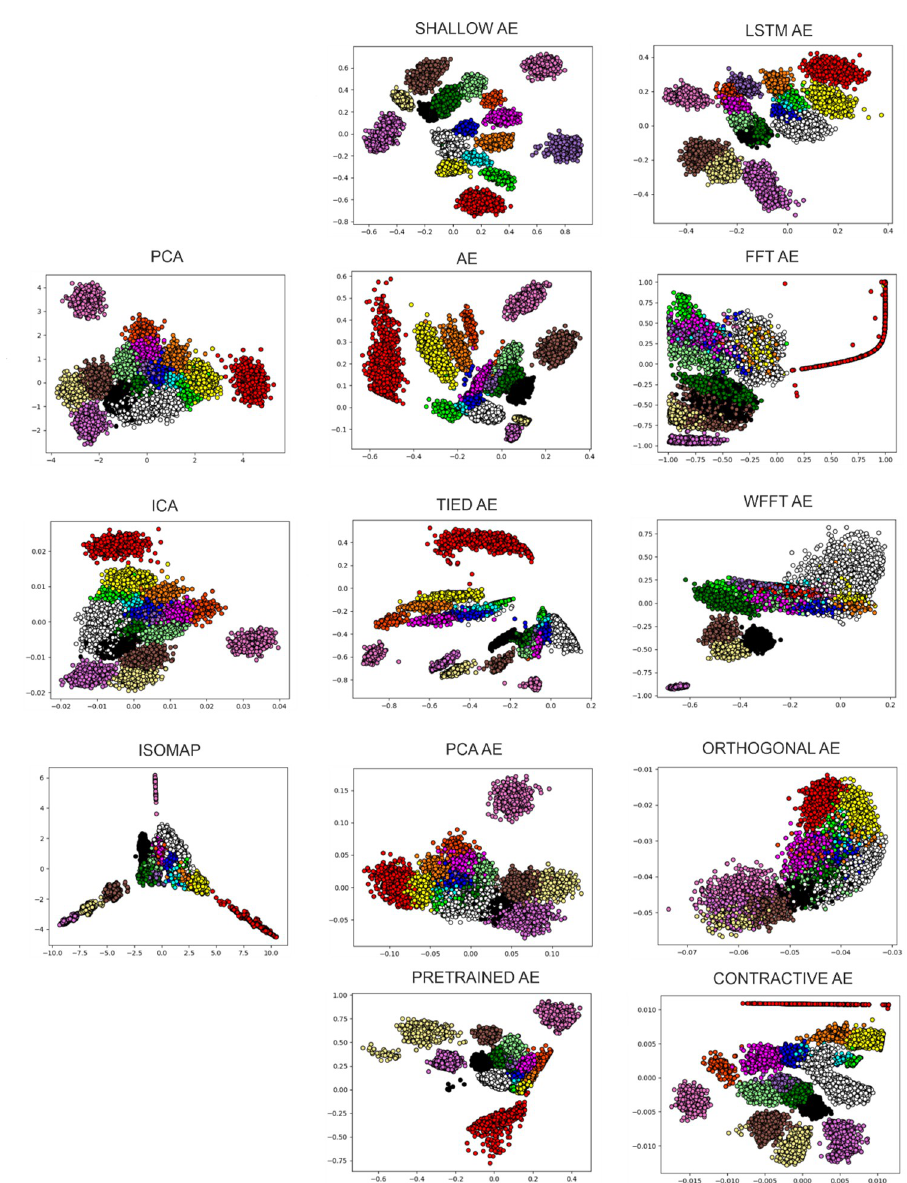
Fig 7. Feature extraction of the Sim1 dataset. All feature extraction applied on Sim1; the colors present the ground truth. 3.3.2. Performance evaluation of real data. The real dataset was recorded extracellularly using a silicone probe that provided 32 channels. Out of the 32 channels, we have chosen four that had an adequate number of spikes. The results of the autoencoder variants and the state- of-the-art feature extraction algorithms on real data, specifically on channel 17, is shown in Fig 8. As previously stated, real data contains no ground truth. From this irrefutable reality, the following implication emerges: We are not able to evaluate the performance of feature extrac- tion separately from that of the clustering. Moreover, out of the metrics presented only the internal metrics remain available. As such, the colours will now represent the labelling of the K-Means clustering algorithm. Thus, the colours will not be corresponding across different